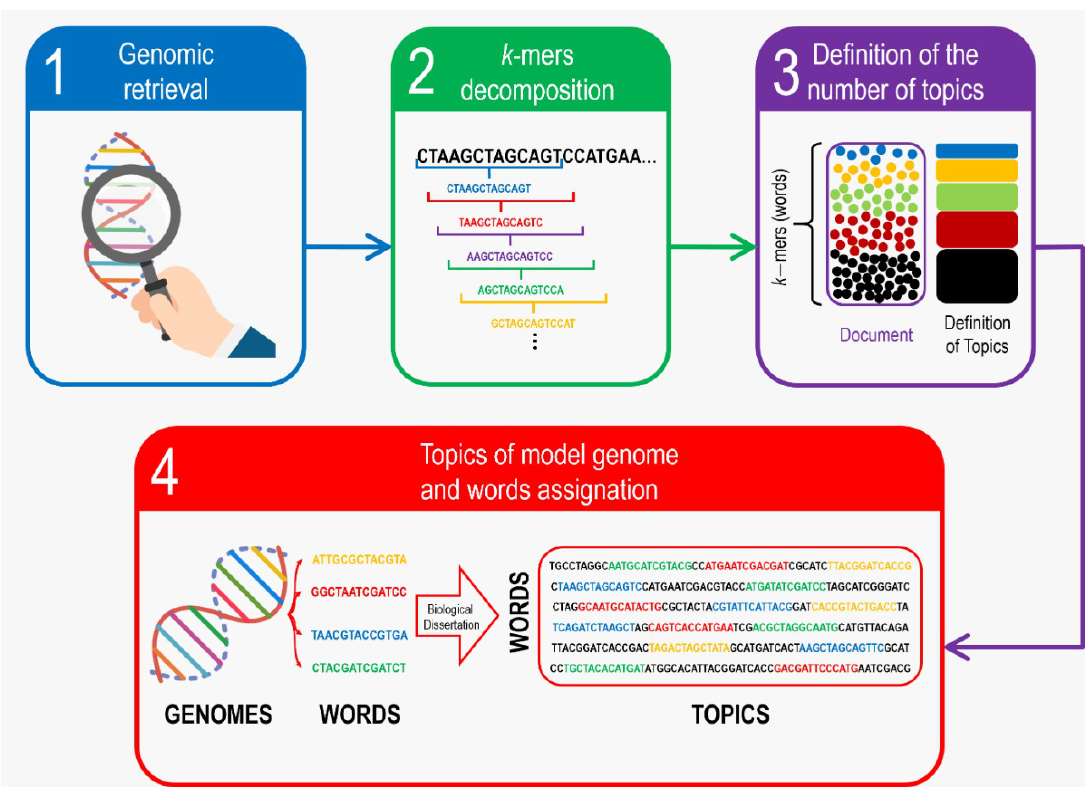
Figure 1. Schematic procedure of Whole-genome k -mer topic modeling association. To-be-compared genomes are retrieved either from databases or from experimental procedures (1) to be decomposed into k -mers (2) and then analyzed in order to determine the adequate topic number (3) to finally perform the topic classification as summarized in